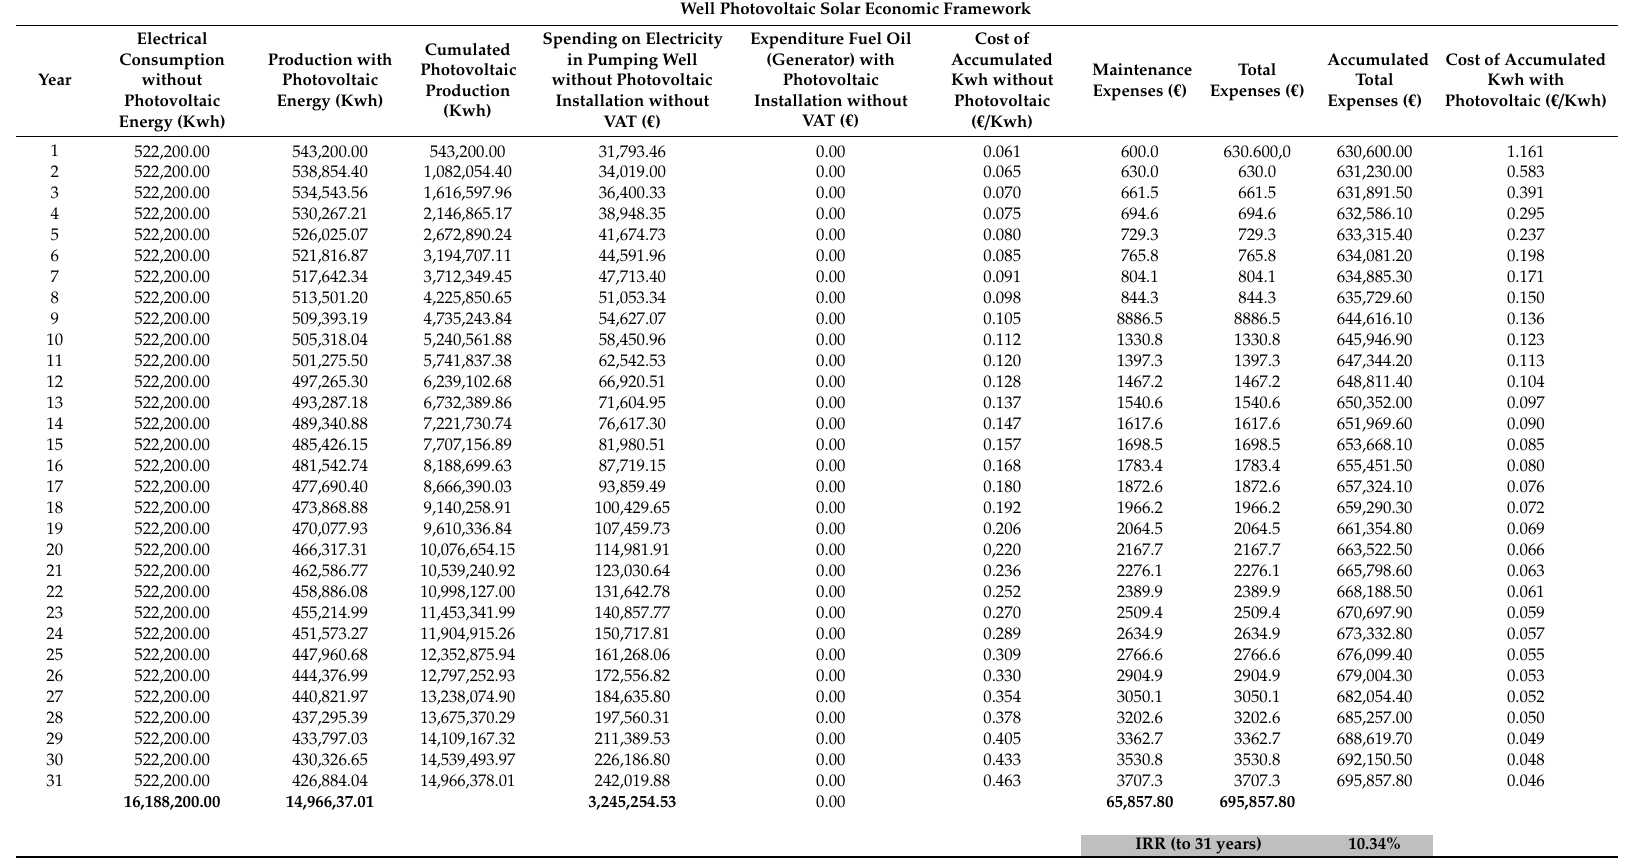
Table 5. Summary procedure for calculating the 31-year internal rate of return (IRR). Well Photovoltaic Solar Economic